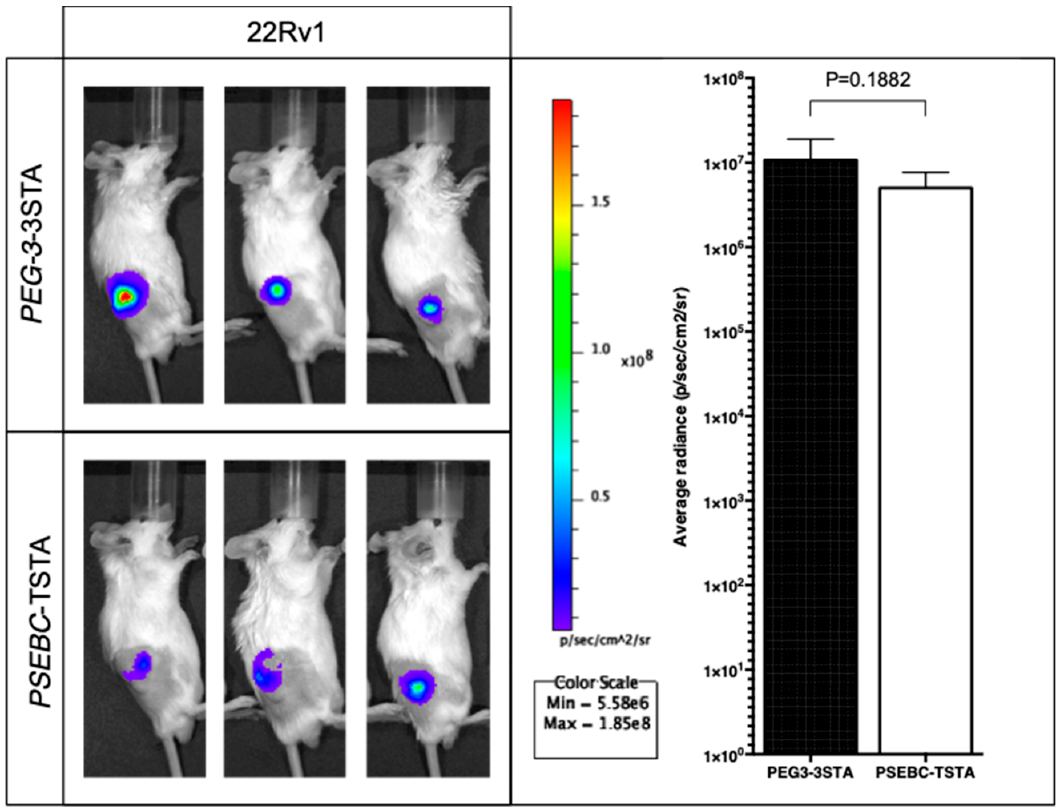
Figure 5. Bioluminescence emitted by the PEG3AP1-3STA system was detected and quantified in vivo. 22Rv1 cell subcutaneous xenografts were generated in SCID beige mice. Following tumor growth and mice randomization for tumor volume, 10 8 infectious viral particles (ivp) of either PEG3AP1 -3STA or PSEBC -TSTA were injected intratumorally. After 96 h, reporter activity was assessed by bioluminescence. Average photon emission per tumor was measured in 22Rv1 mouse xenografts ( n = 3). No statistically significant difference was observed between the PEG3AP1 -3STA and PSEBC -TSTA firefly luciferase activity in the two cell lines tested ( p = 0.1882).